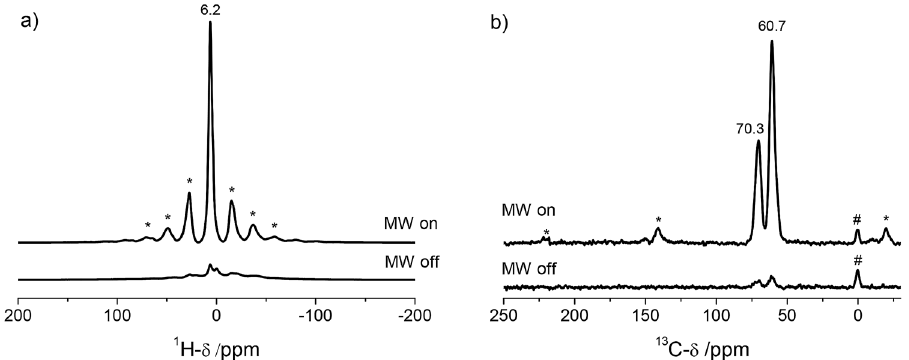
Figure 5. 1 H (a) and 1 H 13 C CP MAS NMR (b) spectra of 15 mM spin labeled eptifibatide 3 in a glycerol-d 8 / D 2 O/H 2 O matrix with (MW on) and without (MW off) microwave irradiation measured at 9.4 Tesla at 8 kHz spinning rate. In the 13 C spectra the two signals at 60.7 ppm and 70.5 ppm refer to the glycerol and the